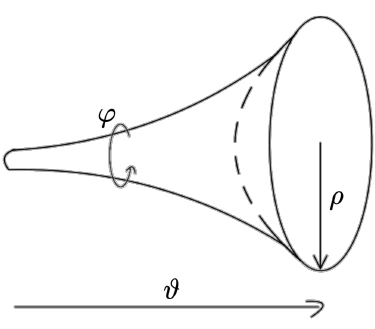
Figure 4 . A constant t slice of the geometry (8.2). The space is foliated by static patch hemispheres with exponentially increasing radius in the ϑ direction and the horizon at ρ = π/ 2 is the surface of this